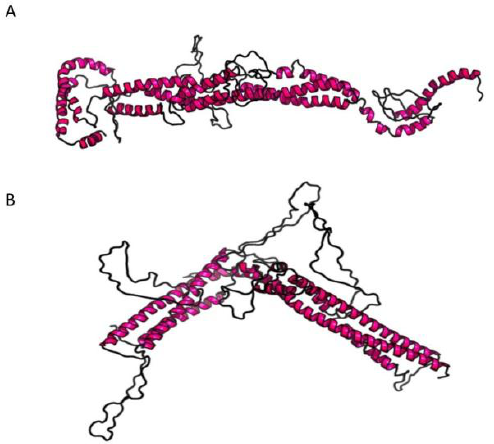
Figure 3. Image of the predicted 3D structure of the stalk domain of protein KIF5A. ( A ) Wild-type structure of the stalk domain; ( B ) Mutated structure of the stalk domain.